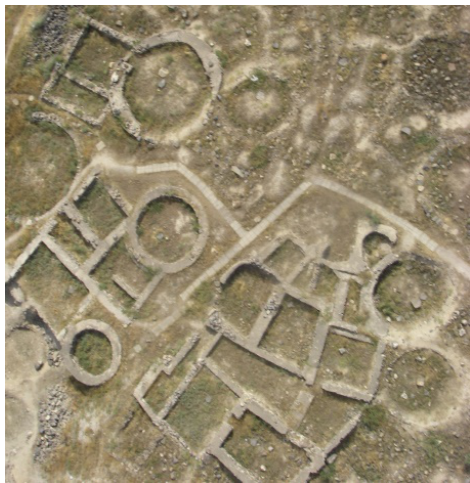
Figure 1. Shengavit; aerial view